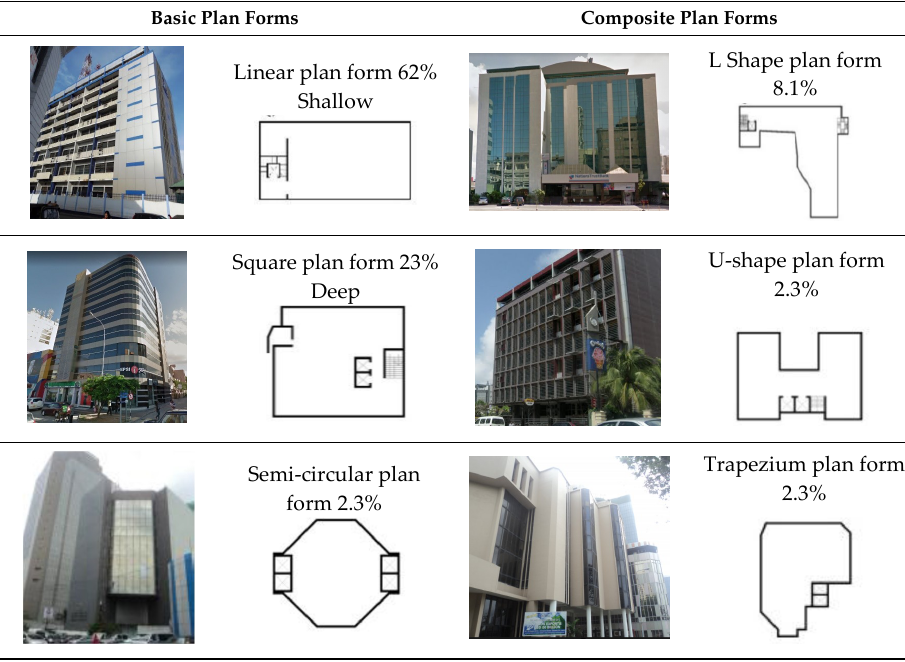
Table 2. Common plan form classification of the building stock in Colombo—linear and shallow plan forms are more common in the stock.